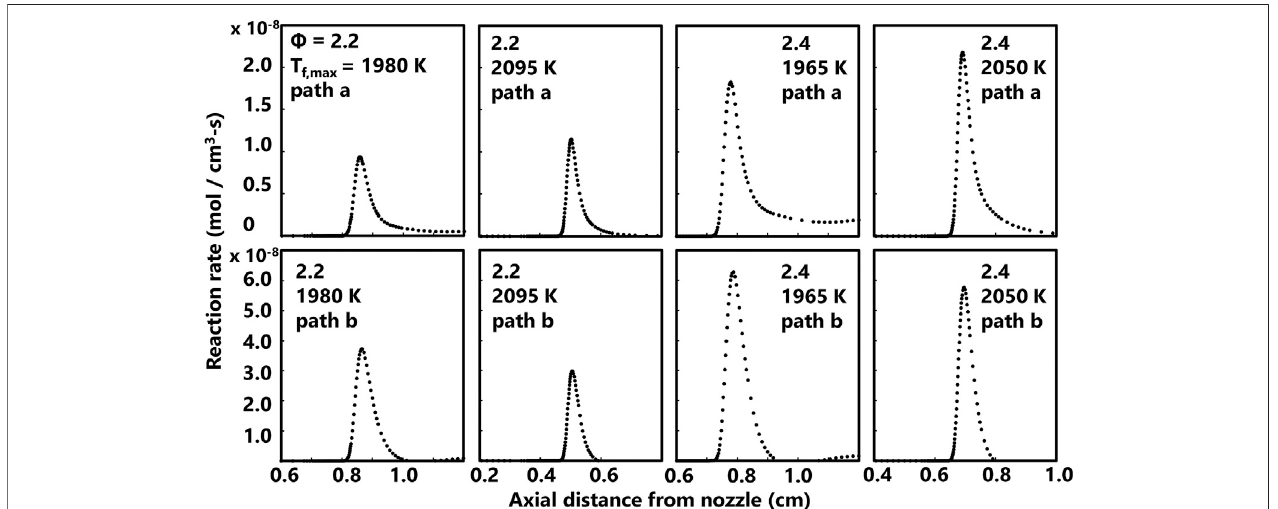
FIGURE 9 | Computed rates of two common naphthalene (A2) production reactions for four fl ames spanning the range of equivalence ratios and fl ame temperatures currently studied. The top row is the axial pro fi le for the net rate of A1 (cid:129) (cid:129) (cid:1) A2 + H A2 (path b).